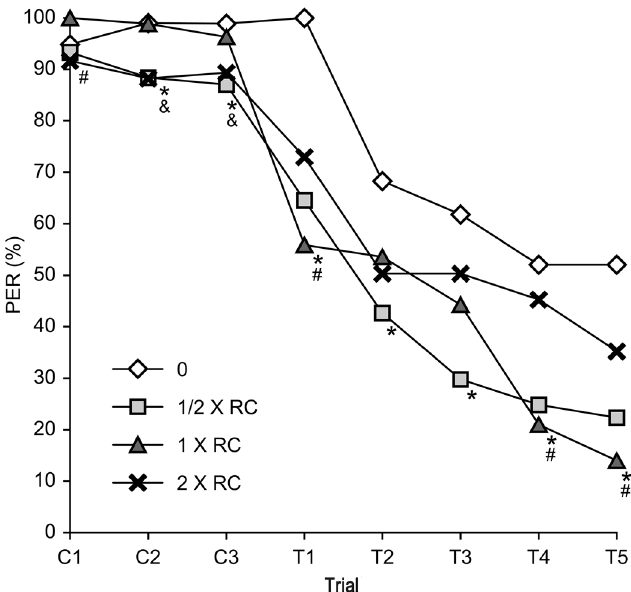
Figure 3. Olfactory learning and memory performance of honeybees after chronic exposure to Roundup. The values represent the means ± SEMs. df = 11. The positive responses at T1 of the control groups were scaled to 100%. Significant differences from the control are indicated by * for 1/2 × RC, # for 1 × RC, & for 2 × RC (p < 0.05).